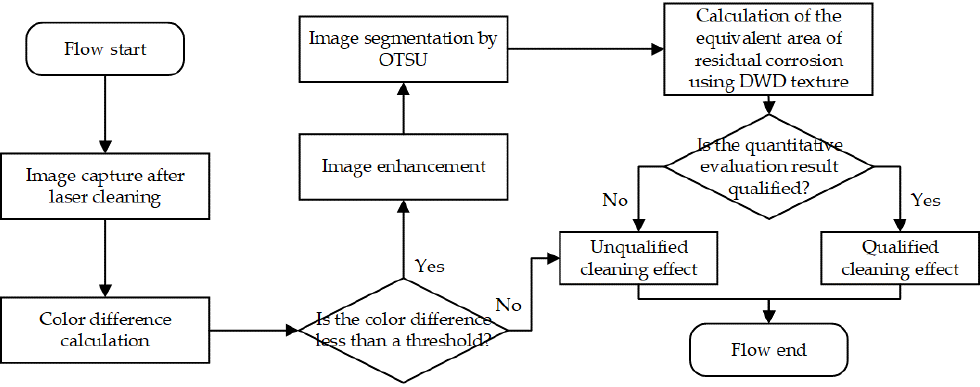
Figure 3. The proposed flow chart of the two-stage cleaning performance evaluation methodology.